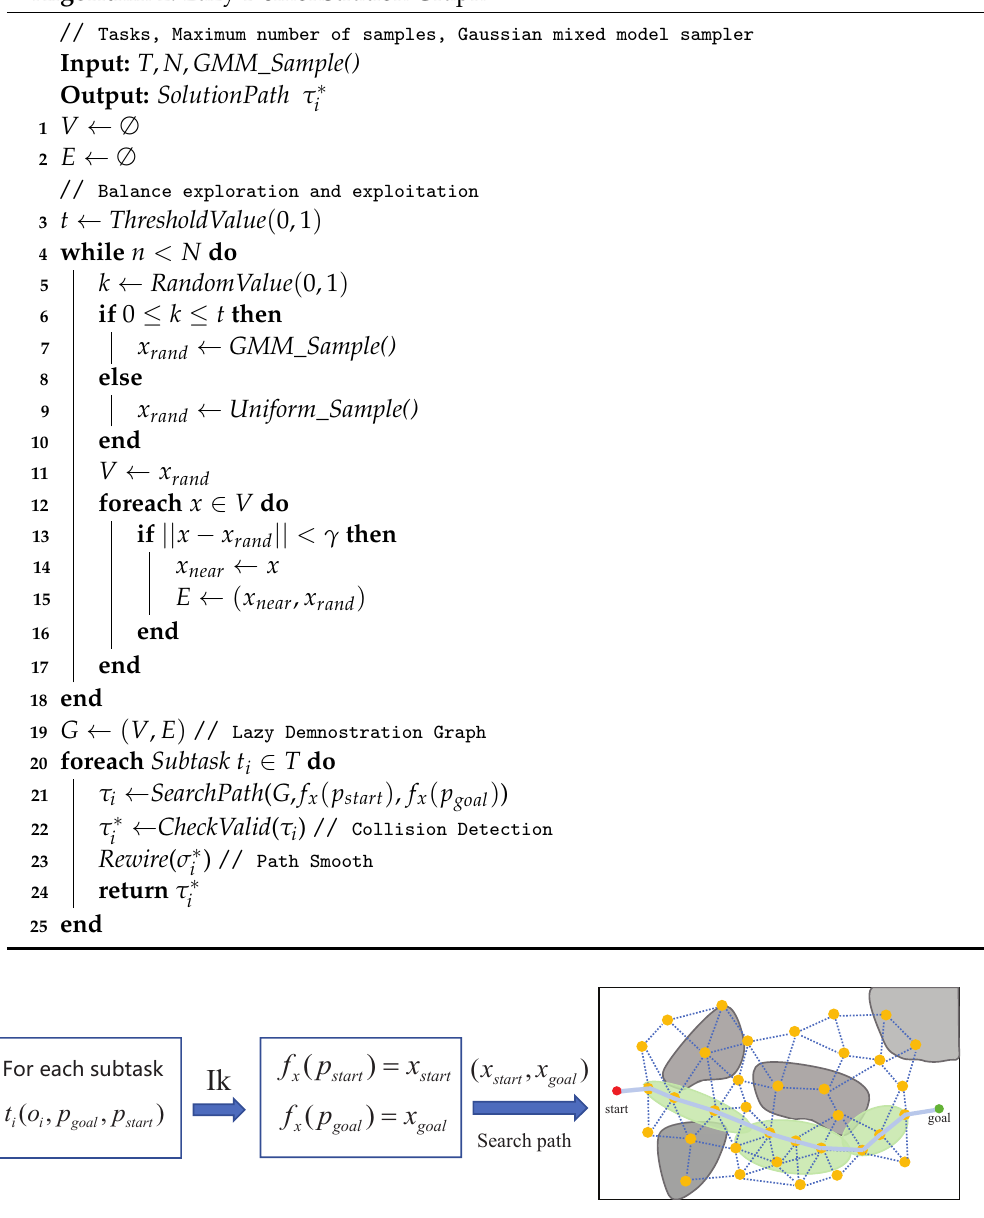
Figure 3. Overall process of solving the repetitive motion planning problem of robotic arm for manipulation tasks using LDG. The manipulation task T contains multiple pick-and-place subtasks and for each subtask t i , the robotic arm is required to move the object from one position to another. the starting and target configurations of the arm can be obtained by inverse kinematics (IK) and then the shortest path is searched using the constructed LDG. the lazy data structure of LDG is kept in each task, which allows invalidating edges, it helps to improve the composition speed on the one hand and adapt the changes of the environment. In this figure, the green ellipse represents Gaussian mixture distribution obtained from prior knowledge training, which is used to place the samples in more promising